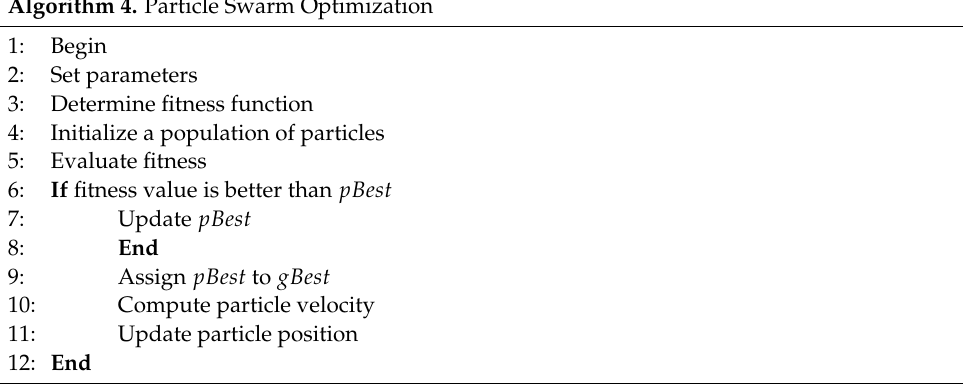
Algorithm 4. Particle Swarm